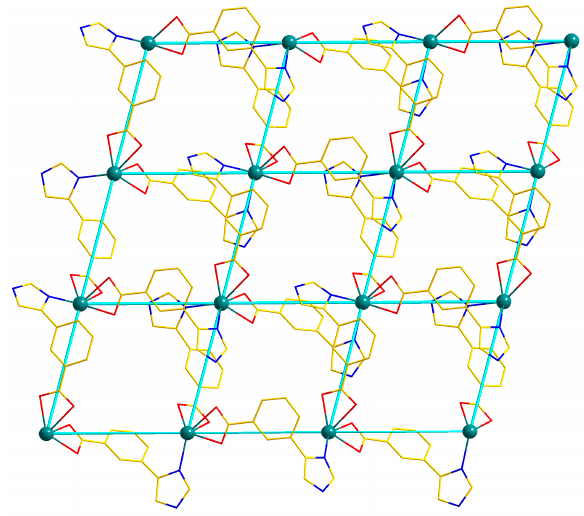
Figure 3. The 2D (4, 4) sql layered network of 1 .